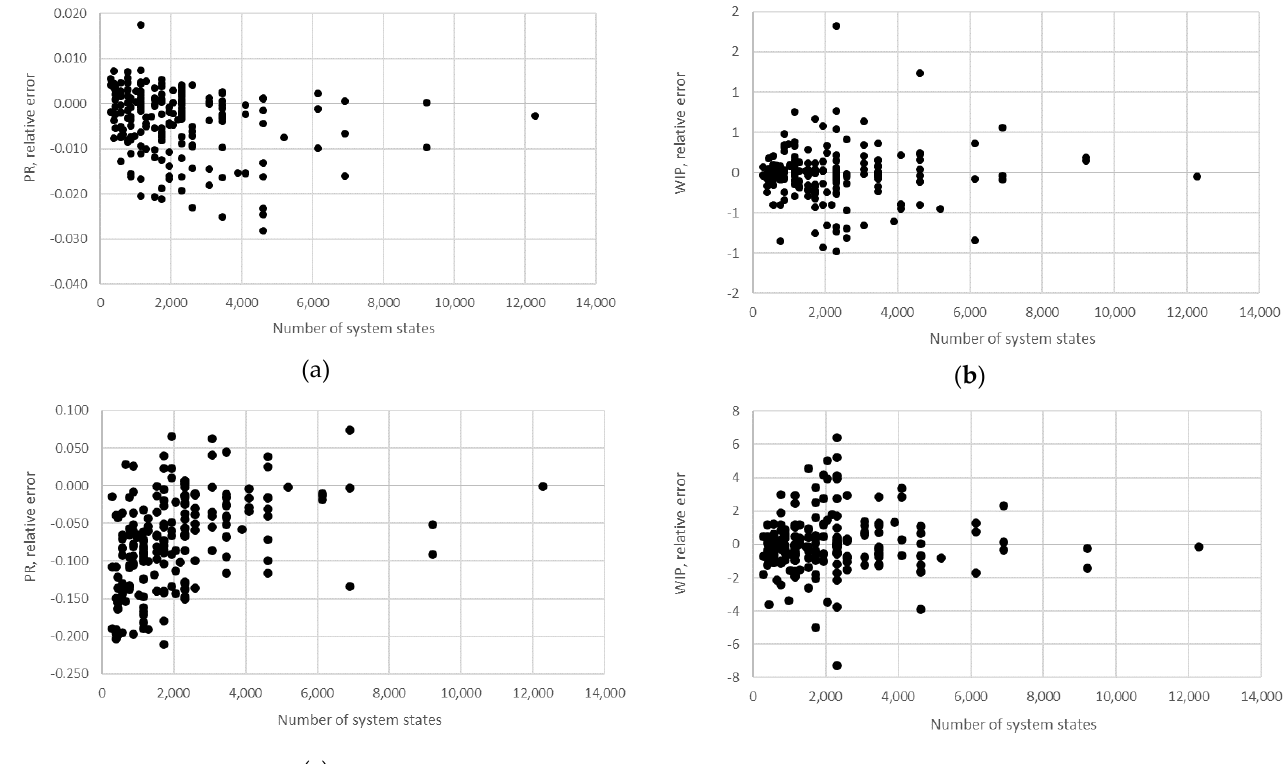
Figure 17. M = 8, relative error obtained using the ( a , b ) AGG procedure and ( c , d ) FSM.